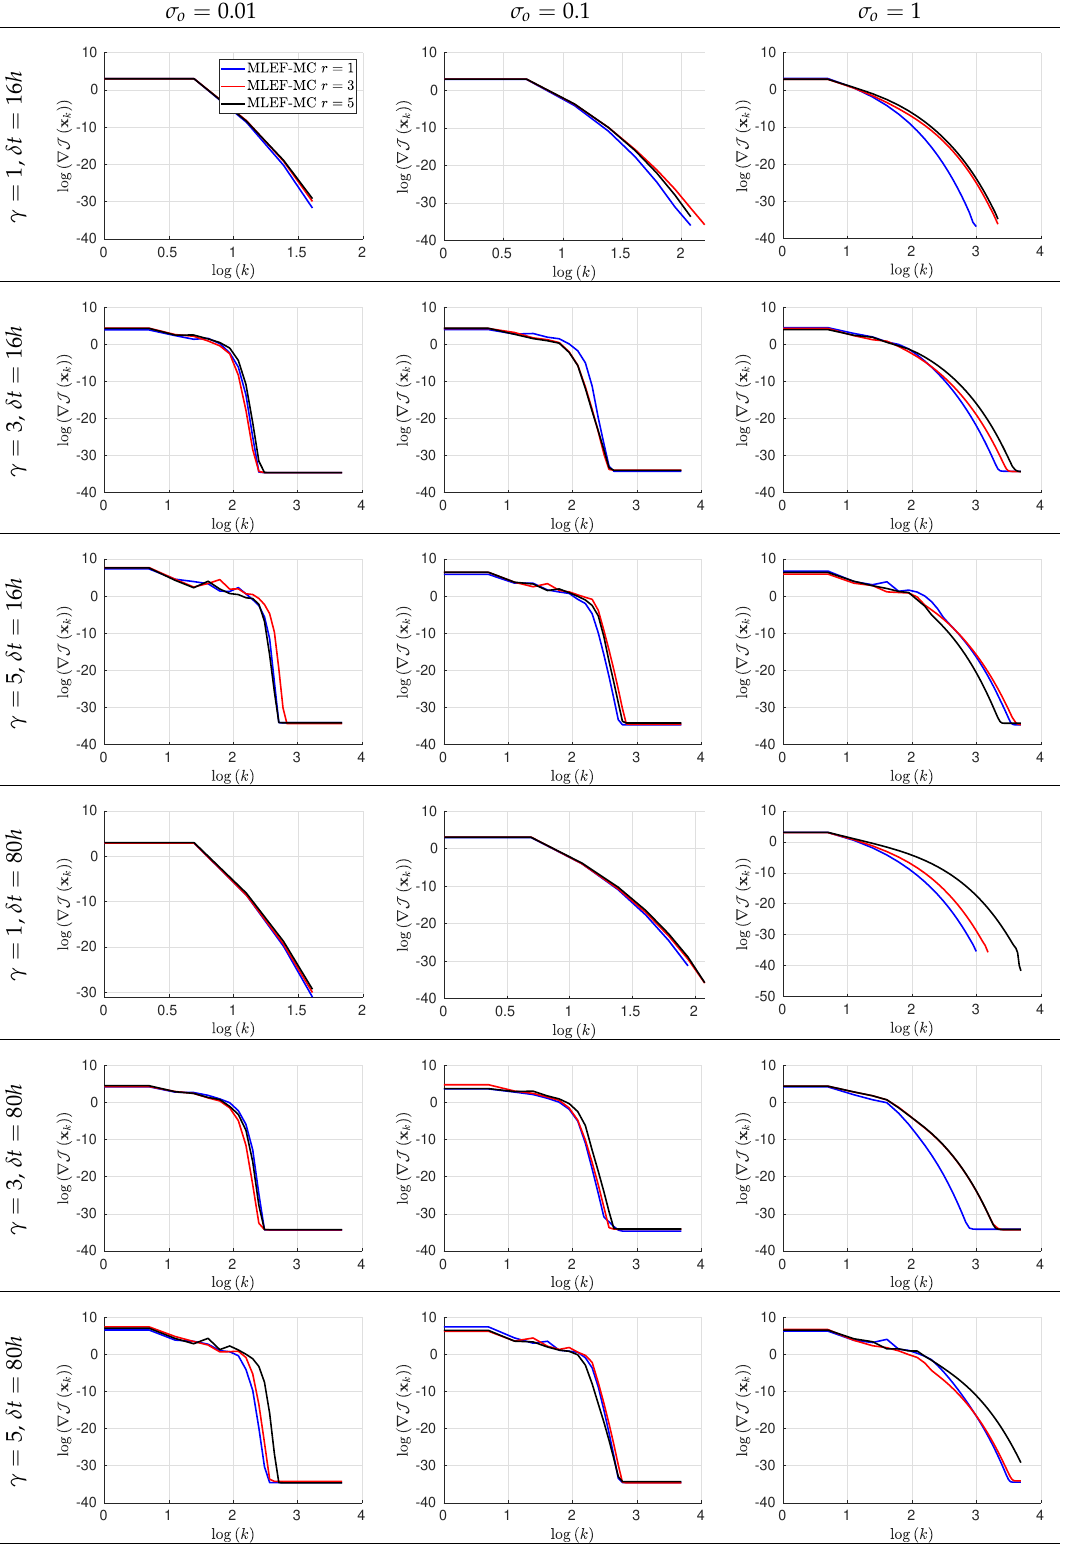
Figure 6. Gradient norms in the log-scale of the MLEF-MC for the initial assimilation step. Different time frequencies of observations were employed during the experiments. The observation coverage from the model state reads s =